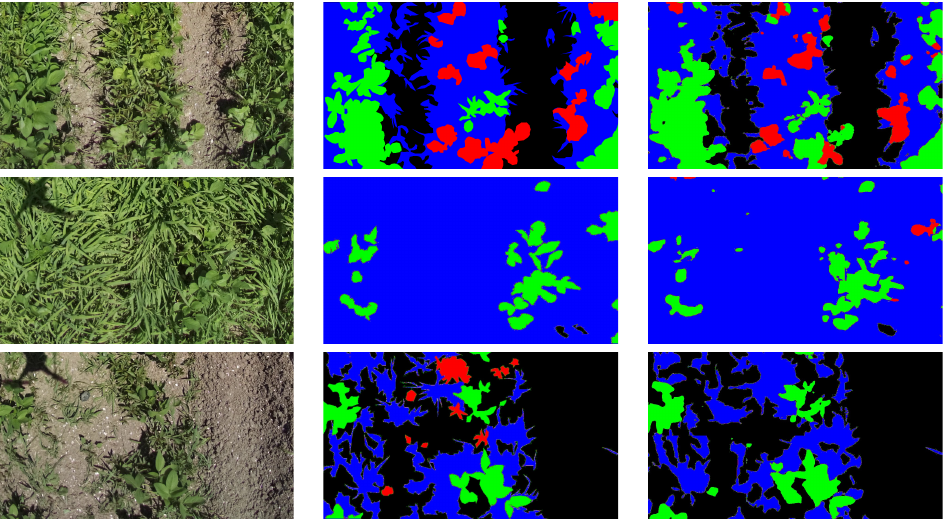
Figure 21. Representative failed Soybeans images: source images ( left ), GT ( center ), and re- sults ( right